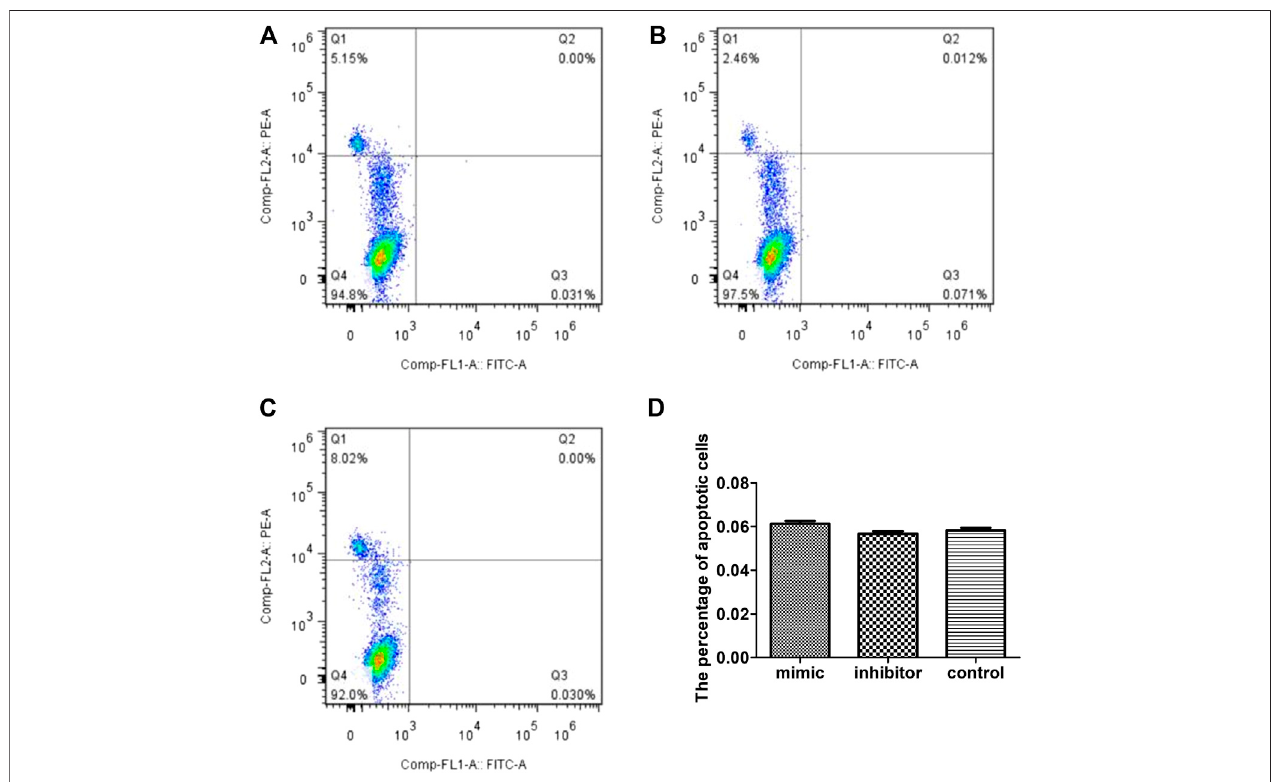
FIGURE 4 | Effect of miR-223 on RAW264.7 macrophage apoptosis. Effect of miR-223 mimics (A) , miR-223 inhibitors (B) and the scrambled control (C) on RAW264.7 macrophage apoptosis. Representative results are shown. (D) Comparison ofthe percentage ofapoptotic cells amongthe three groups. The percentage of apoptotic cells (annexin V-positive/PI-negative) was 0.061 om0.028%, 0.056 .00.027% and 0.058 020.026%, respectively, in the miR-223 mimic group, miR-223 inhibitor group and scrambled control group. The differences among the groups were not statistically signi fi cant ( n (cid:2) 5, p >